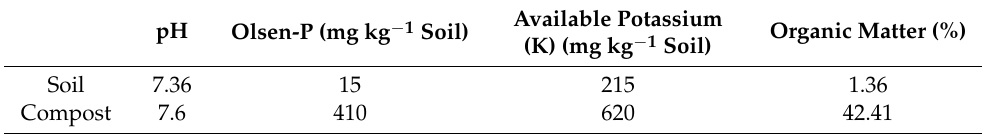
Table 1. Soil and compost physicochemical properties.